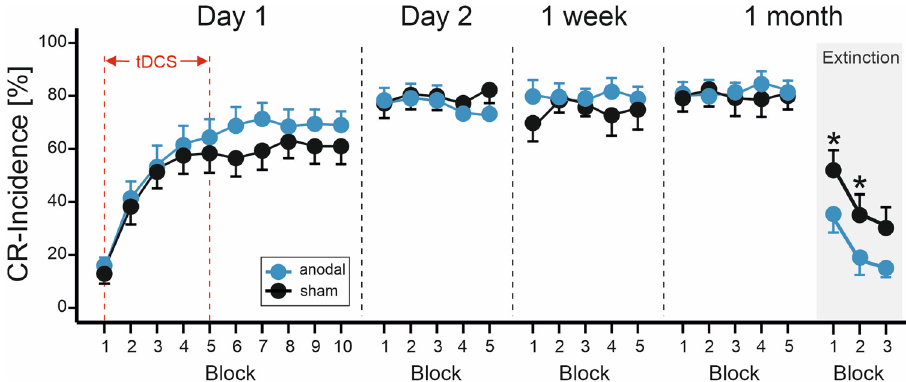
Figure 2. Group mean percentage CR incidence and standard errors (SE) on days 1, 2, 8 (1 week) and 29 (1 month). Ten blocks a 10 paired CS–US trials were presented on day 1, five blocks a 10 paired CS–US trials on days 2, 8 and 29. In addition, 3 blocks a 10 CS-only extinction trials were presented on day 29. Blue filled circles = anodal group, filled black circles = sham group. * indicates significant effects in post-hoc pairwise comparisons.